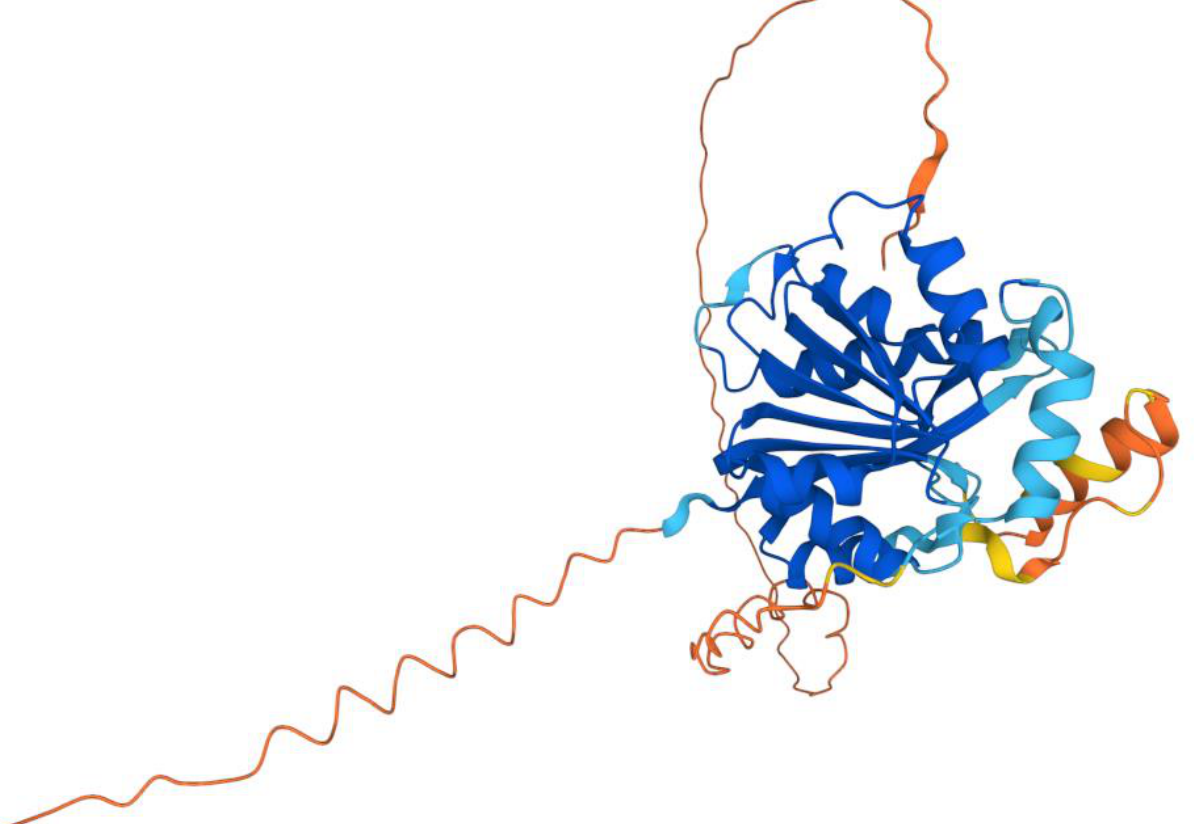
Figure 4. AlphaFold model of human COQ3. Model color corresponds to model confidence in each region. Very high confidence in dark blue (pLDDT > 90); confident in light blue (90 > pLDDT > 70); low confidence in yellow (70 > pLDDT > 50); very low confidence in orange (pLDDT < 50). pLDDT is a measure of per-residue confidence. pLDDT < 50 is a reasonably strong predictor of disorder for the corresponding residue. Figure was generated by the AlphaFold Protein Structure Database; adapted with permission from [39,54].